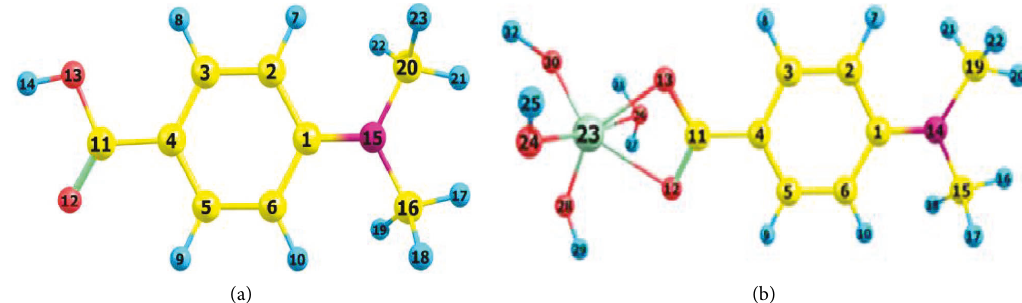
Figure 1: The atom numbering of the optimized structure of (a) 4-DMABA (D1) and (b) 4-DMABA-T +4 (OH)